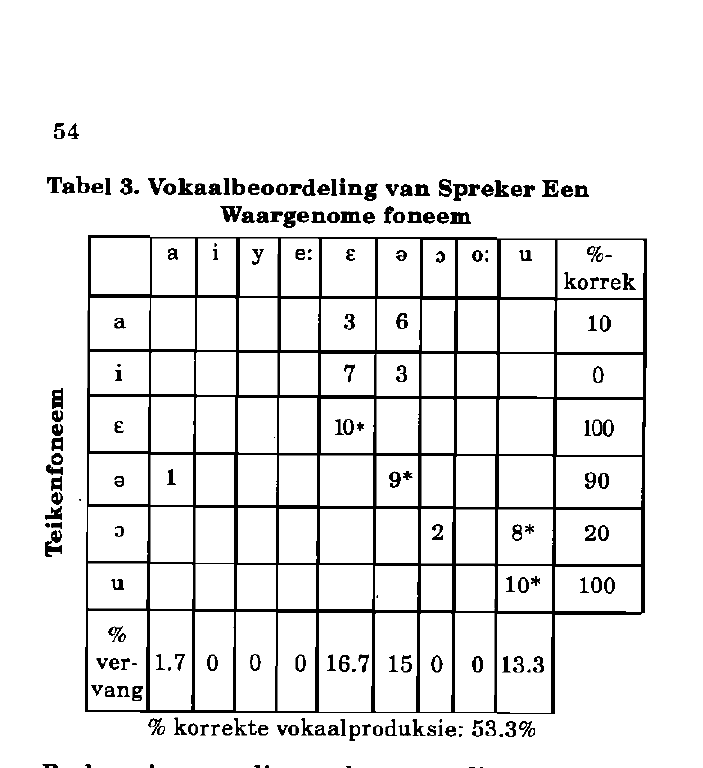
In tabel 5 word die vokaalbeoordelingsmatriks vir Spreker Twee afsonderlik aangetoon. Die uiteensetting is soos in tabel 3. Beskrywing van die resultate van die